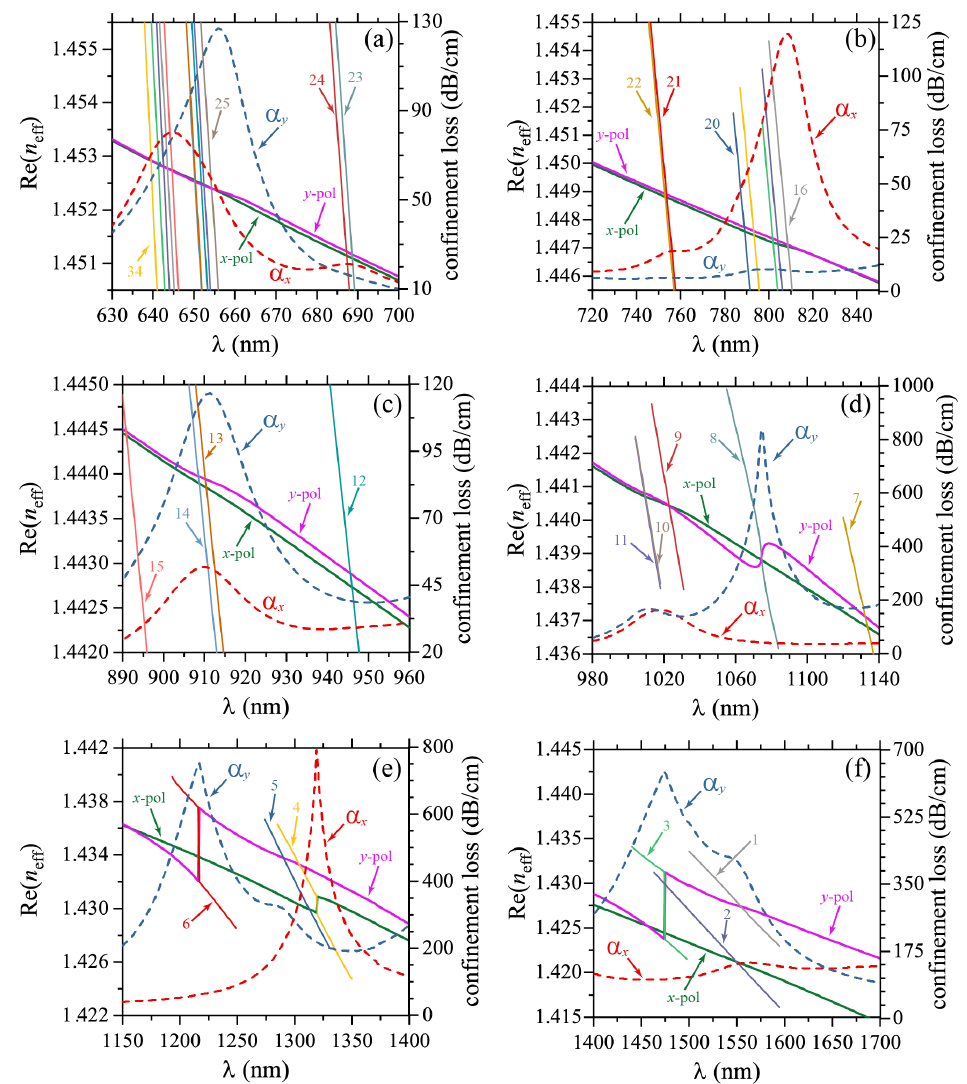
Figure 2. The Re ( n ef f ) , for the SPR and fiber modes, and confinement loss ( α x , y ) are plotted in the wavelength range from λ = 630 nm to λ = 1700 nm. A large set of SPR modes was identified which, for visualization purposes, were numbered from 34 to 1 and presented in ( a ) 34 to 23, ( b ) 22 to 16, ( c ) 15 to 12, ( d ) 11 to 7, ( e ) 6 to 4 and ( f ) 3 to